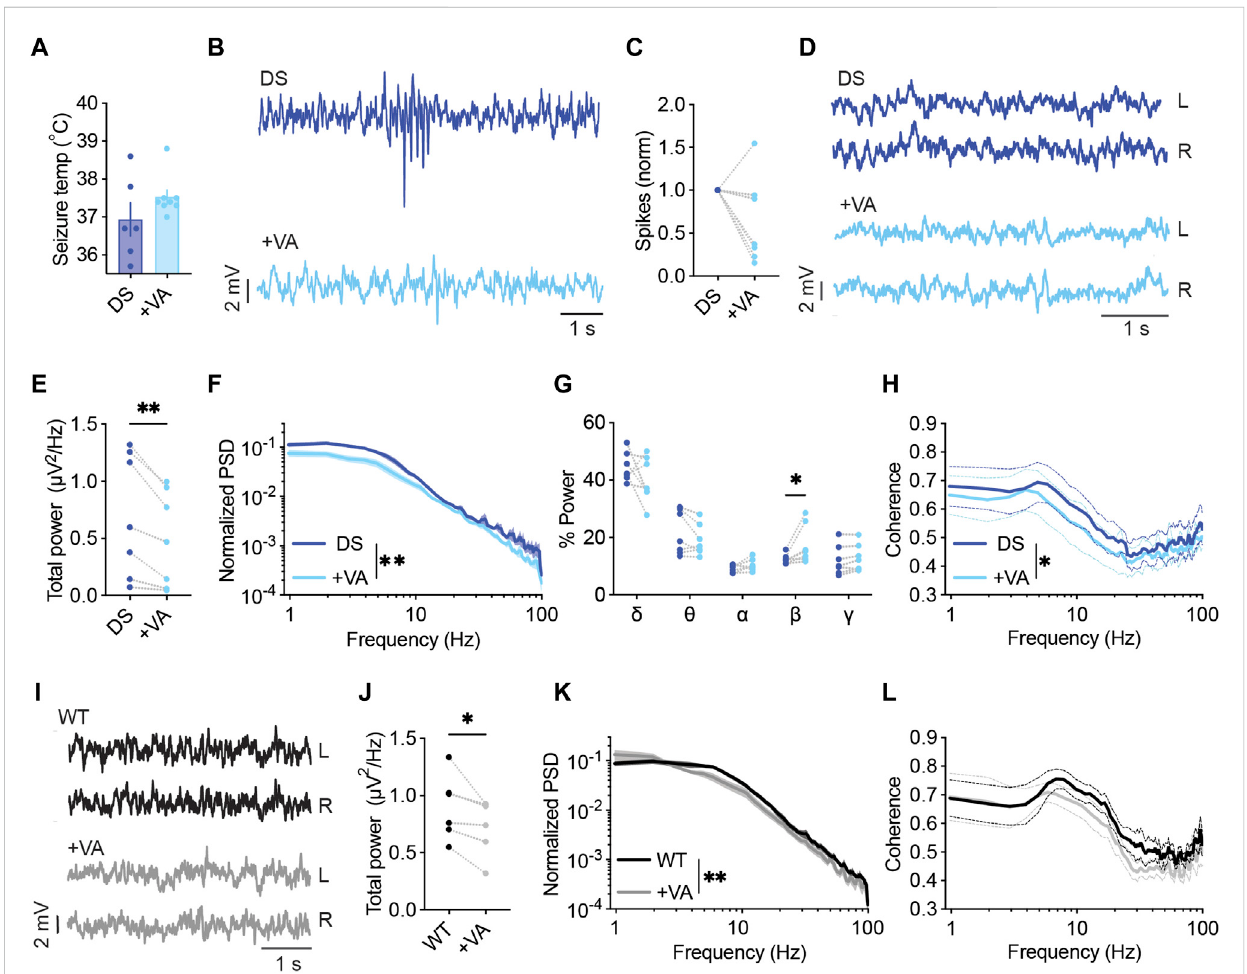
FIGURE 2 VA modulates the power and spectral properties of background ECoG. (A) Thermally induced seizures in mice treated with vehicle or VA (300 mg/kg).DSmiceinjectedwithsalineasthevehicle,n=6;DSmiceinjectedwithVA,n=8. (B) RepresentativetracesofECoGsfromDSmicedepicting epileptic activitybefore andafter VAadministration. (C) The change ininterictal spike frequency. (D) Representative tracesof background activity. (E) The effect of VA on total power. (F) ECoG power density pro fi les normalized to the total power prior to VA administration. (G) Relative power in each frequency band, before and after VA. (H) Interhemispheric coherence plotted over the 1 – 100 Hz spectrum. DS, n = 7. (I) Representative traces of backgroundECoGs from WT mice before and after VA administration. (J) The effect of VA on total power. (K) ECoG power density pro fi les normalized to the total power prior to drug administration. (L) Interhemispheric coherence plotted over the 1 – 100 Hz spectrum. WT, n = 5. * p < 0.05, ** p <